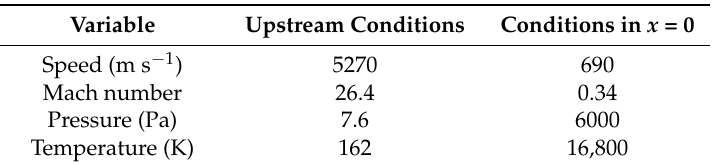
Table 2. Jump conditions in x = 0 due to the Rankine–Hugoniot assumption at 45 km altitude corresponding to the peak